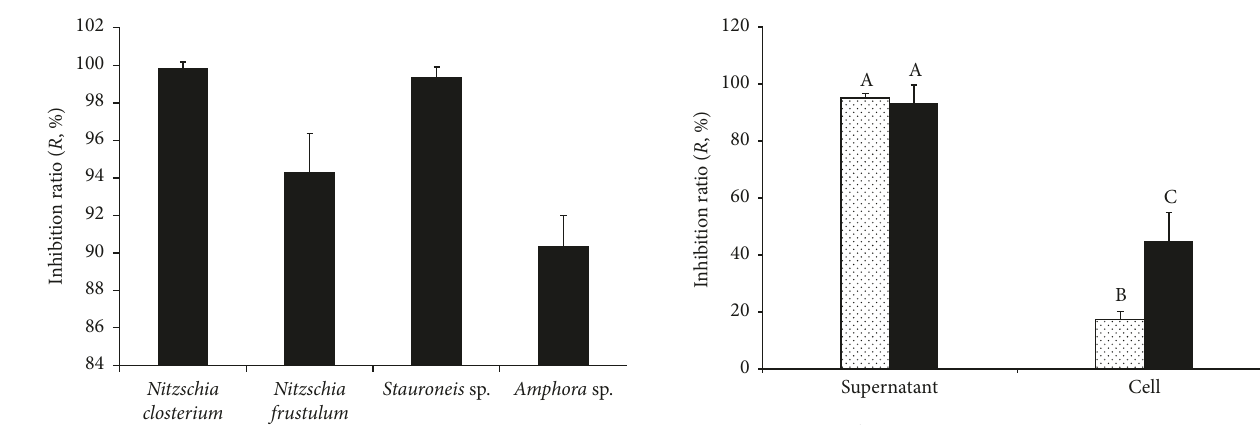
Figure 2: Phylogenetic tree based on 16S rDNA of strain UST050418-708. The evolutionary history was inferred using the neighbour- joining method. The numbers at the nodes indicate the bootstrap values based on neighbour-joining analyses of 1000 sample data sets. The tree is drawn to scale, with branch lengths in the same units as those of the evolutionary distances used to infer the phylogenetic tree. The evolutionary distances were computed using the Maximum Composite Likelihood method and are in the units of the number of base substitutions per site. Bar of 0.01 represents per nucleotide position. The numbers in parentheses are accession number of sequences. Evolutionary analyses were conducted in the MEGA6 software